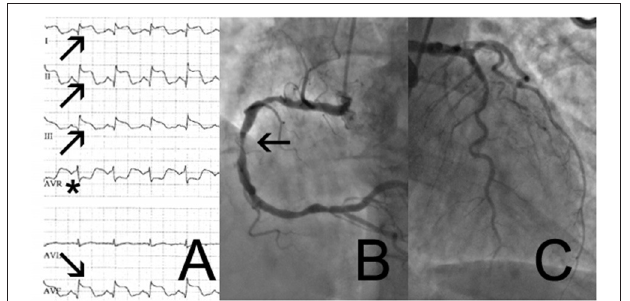
FIGURE 1 | 6-lead monitor ECG (A) with ST-elevation in the inferolateral leads I,II,III,aVF (arrows) and ST depression in aVR (asterix). Coronary angiogram showing right coronary artery (B) with significant stenosis of the mid section of the right coronary artery (arrow) and coronary atheromatosis with not significant coronary artery disease of the left circumflex- and left anterior artery (C) .